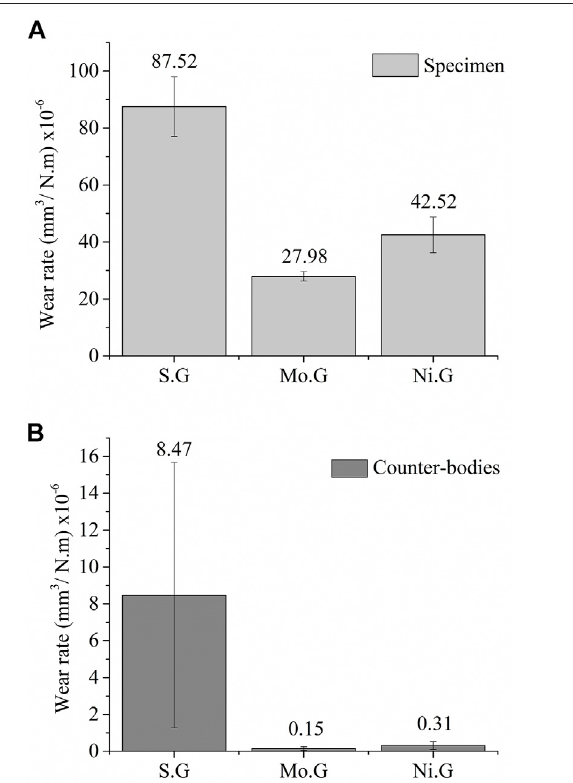
FIGURE 11 | Wear rates after reciprocating sliding tests: (A) specimens and (B) counter